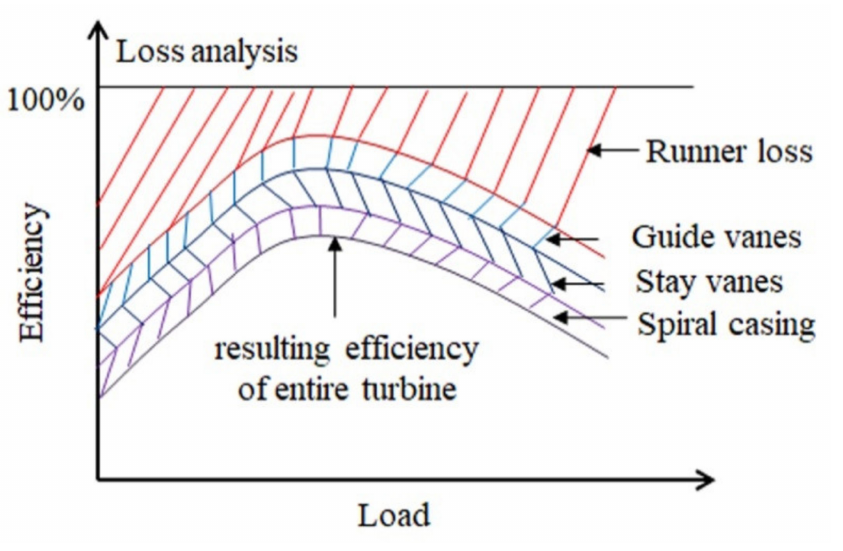
Figure 19. Turbine loss